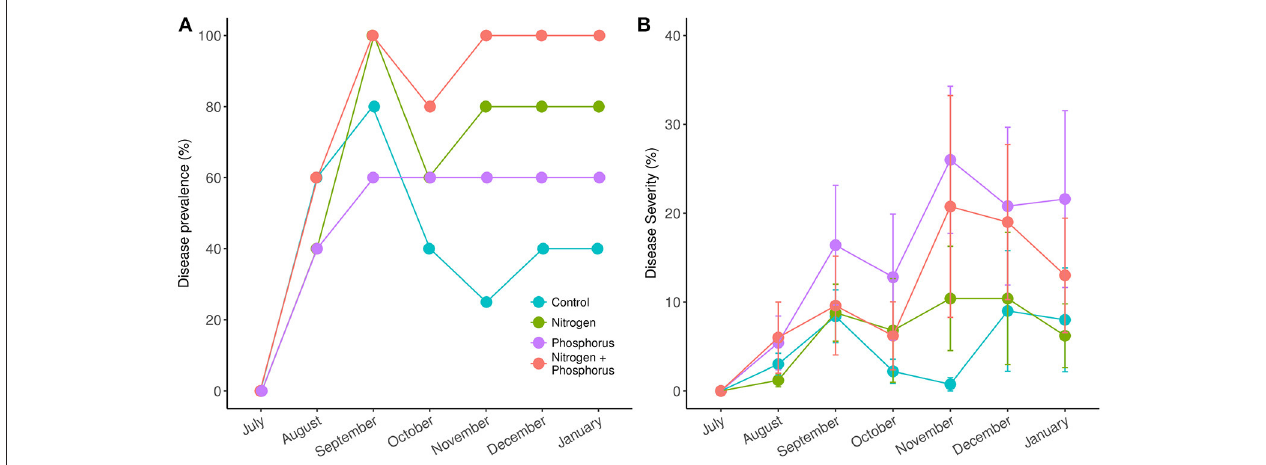
FIGURE 3 | Prevalence (A) and severity (B) of Dark Spot Syndrome in Siderastrea siderea corals during the course of study. Measurements taken in July were taken prior to nutrient treatment, while August, September, and October measurements were taken post treatment. Disease prevalence was calculated as the proportion of diseased individuals at each time point. Disease severity was calculated as the proportion of diseased tissue in each individual.